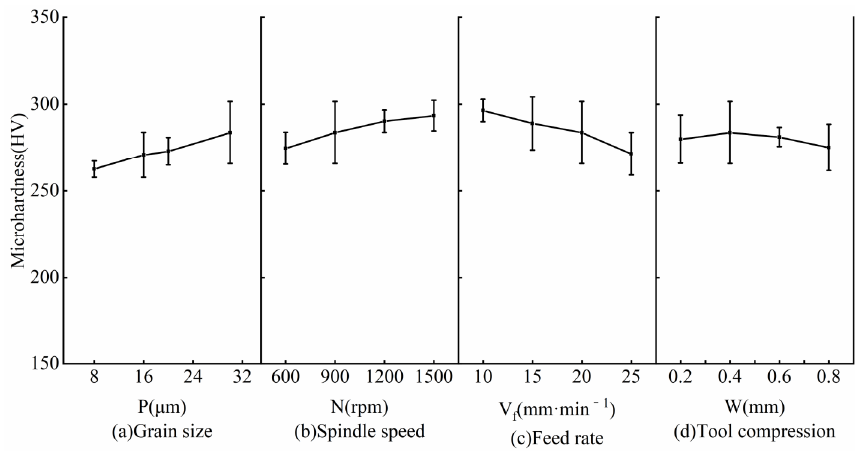
Figure 13. Influence of grinding parameters on surface microhardness: ( a ) Grain size, ( b ) Spindle